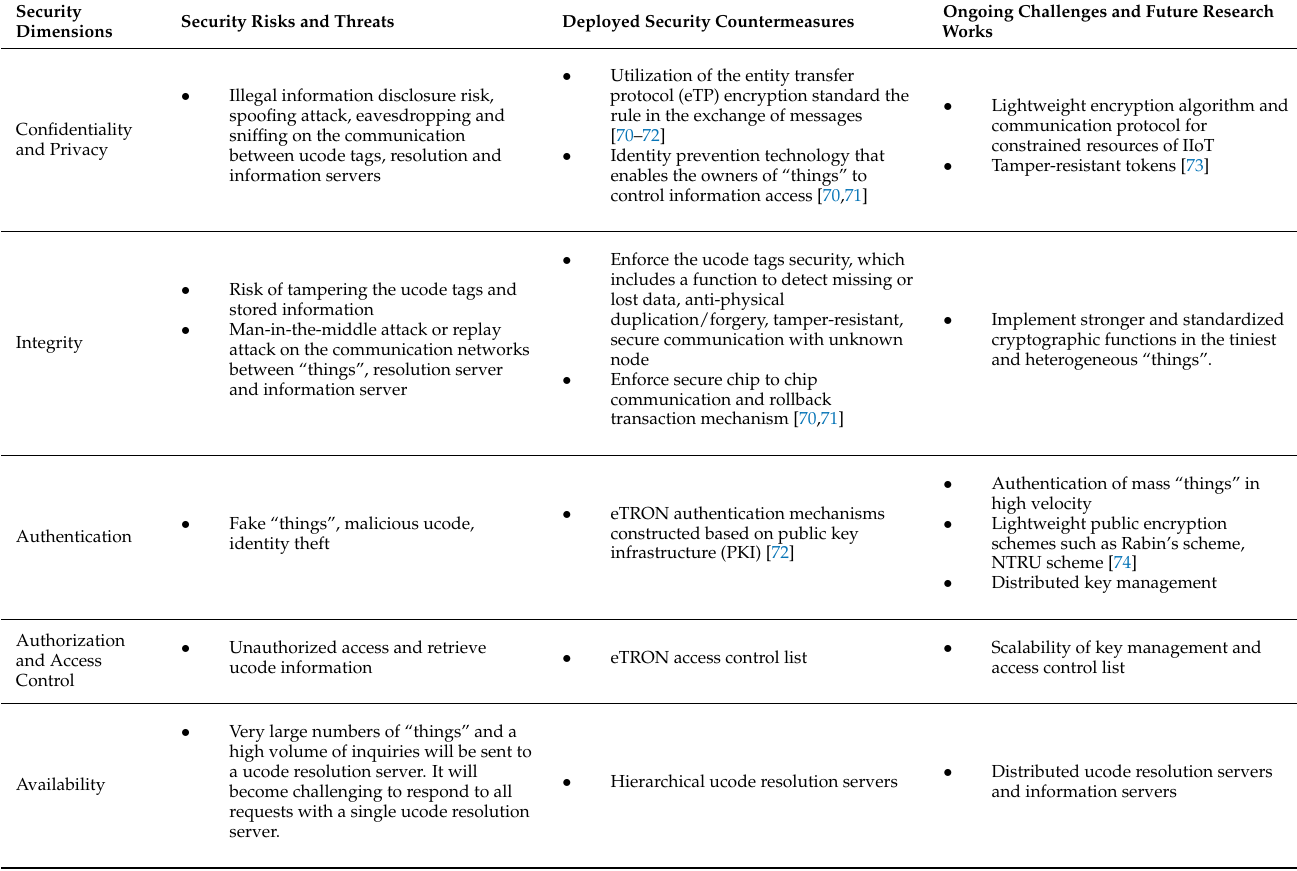
Table 5. Security analysis on ubiquitous code (ucode) and its